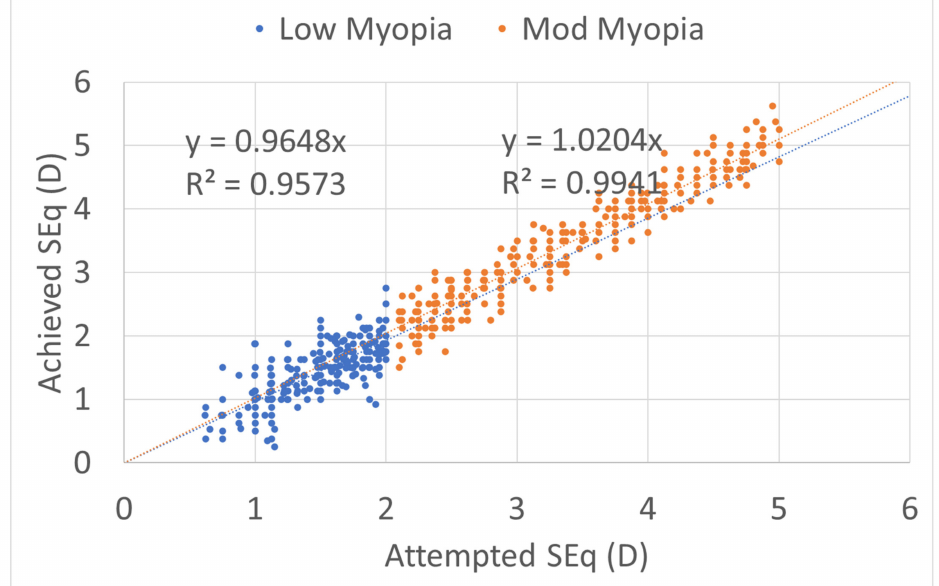
Figure 4. Predictability achieved versus attempted spherical equivalent (SEQ) for both myopic groups, low myopia with a small undercorrection, and moderate myopia with a small overcorrection, regression analysis and R2 coefficient of determination in both groups near to 1. The predictability of the treatments was not different between the two myopic ranges. The scattergram of achieved vs. attempted correction was very similar for both groups.